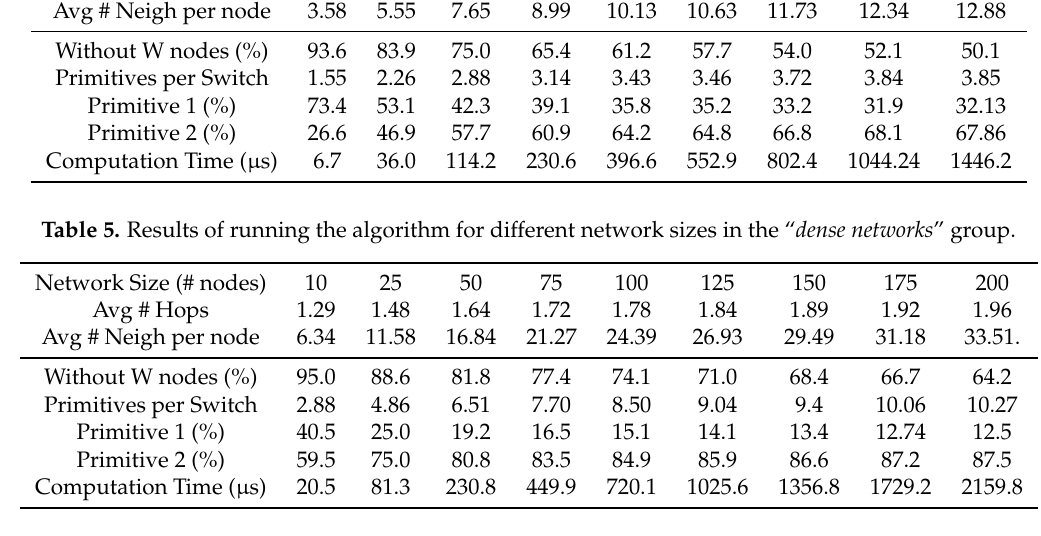
Table 4. Results of running the algorithm for different network sizes in the “ sparse networks ” group. Network Size (# nodes)